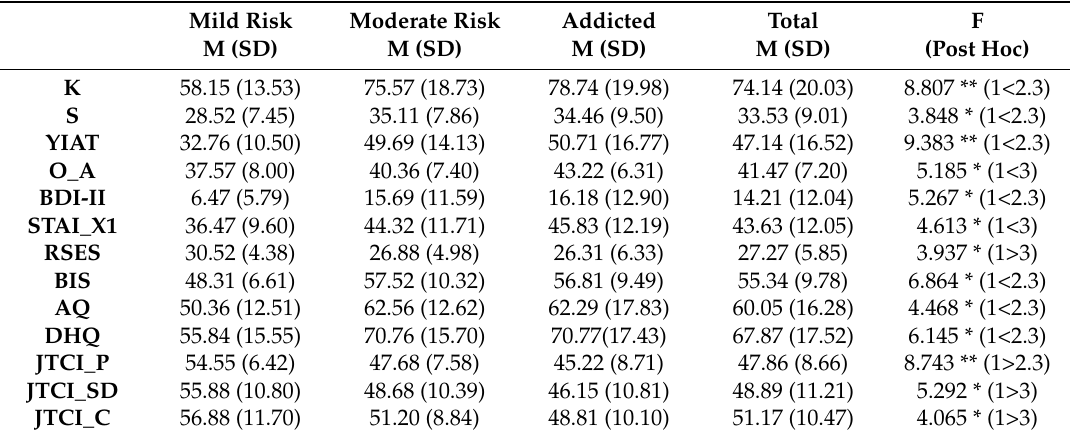
Table 4. Differences in Internet Gaming Disorder symptoms and Clinical variables between Diagnostic Interview for Internet Addiction